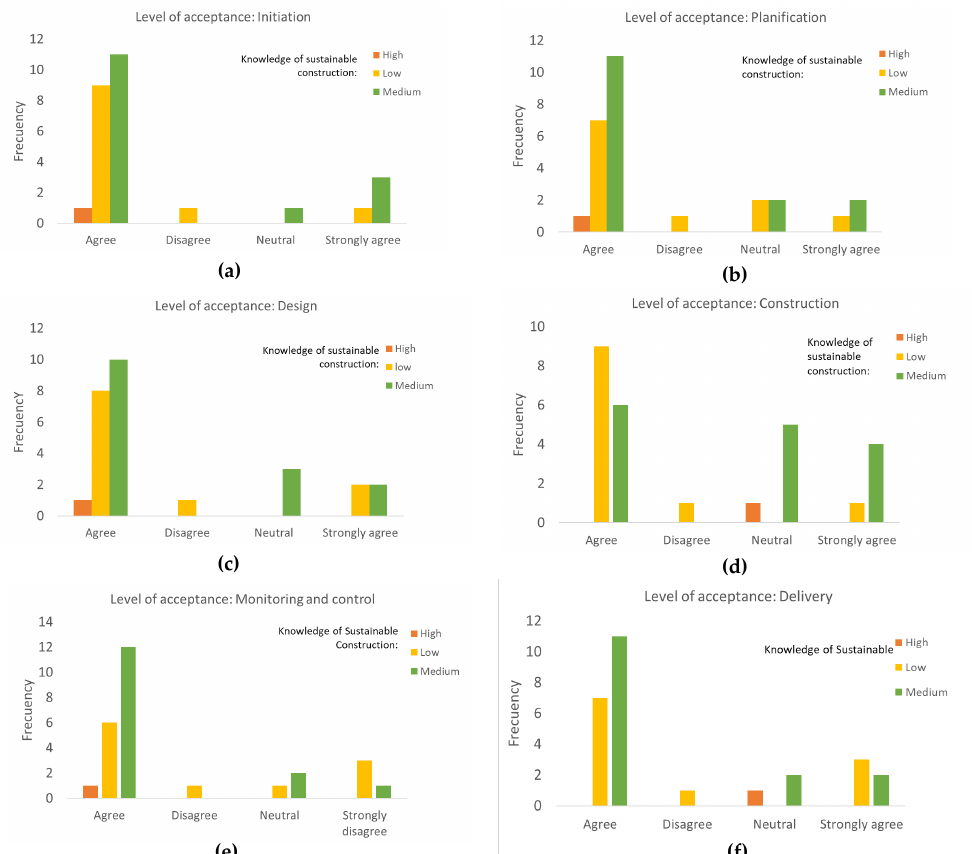
Figure 13. Results of phase acceptance based on the level of knowledge about sustainable con- struction: ( a ) initiation, ( b ) planning, ( c ) design, ( d ) construction, ( e ) monitoring and control and ( f )